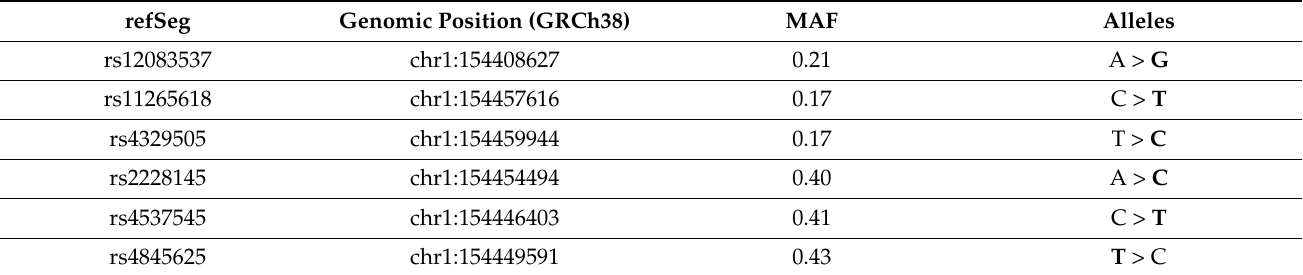
Table 1. Selected functional polymorphisms in the IL6R